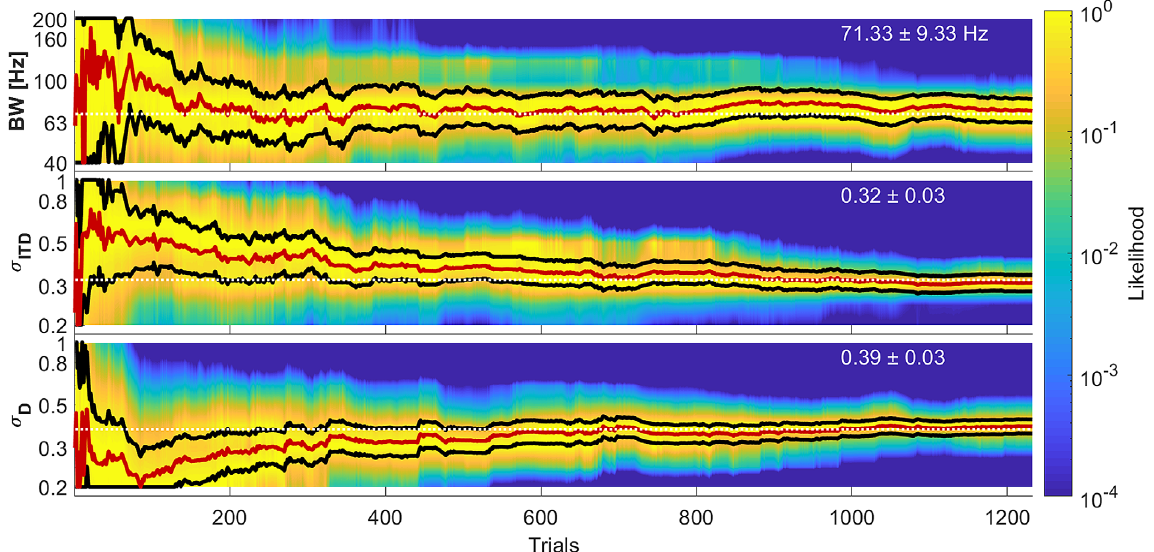
Figure 5. Example result of the model-based measurement steering with an arti fi cial test subject. In general, the same experiment is shown as in Figure 4 with the difference that here, the model used as an arti fi cial test subject was modi fi ed: the gammatone fi lter, which simulates the basilar membrane, was replaced with a DRNL fi lter. Due to this new fi lter, the equivalent rectangular bandwidth was 69 Hz (at 70 db SPL), instead of 79 Hz in the previous example. The other two parameters were identical to the previous example ( r ITD : 0.33, r D : 0.38).